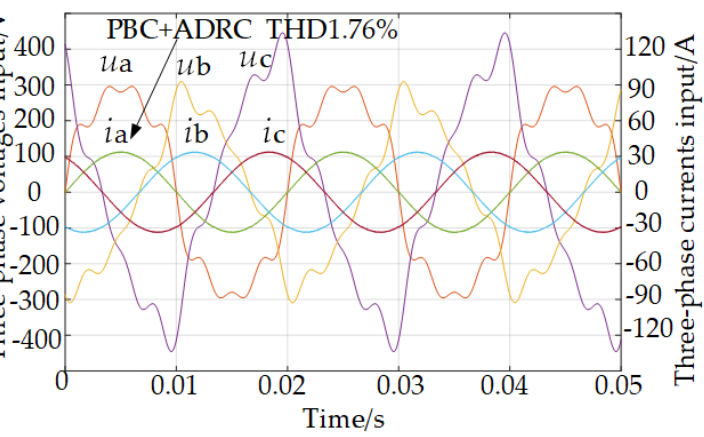
Figure 6. Three − phase unbalanced grid voltages and three − phase input currents after harmonic 6